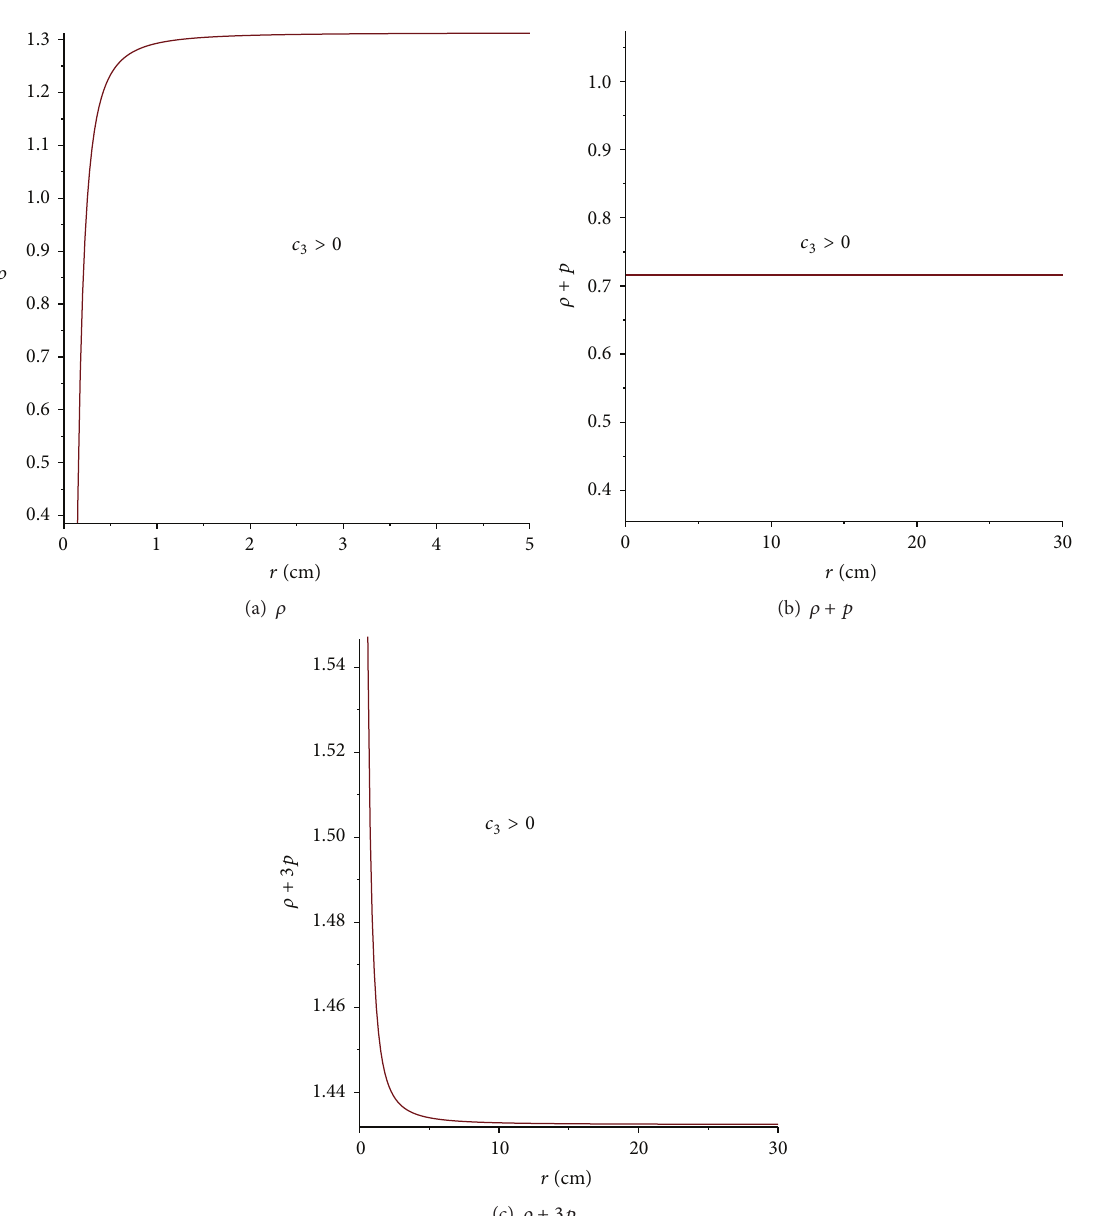
Figure 1: Energy conditions of the first model: the constant 𝑐 3 assumes a positive value so that the density is positive and also the pressure.